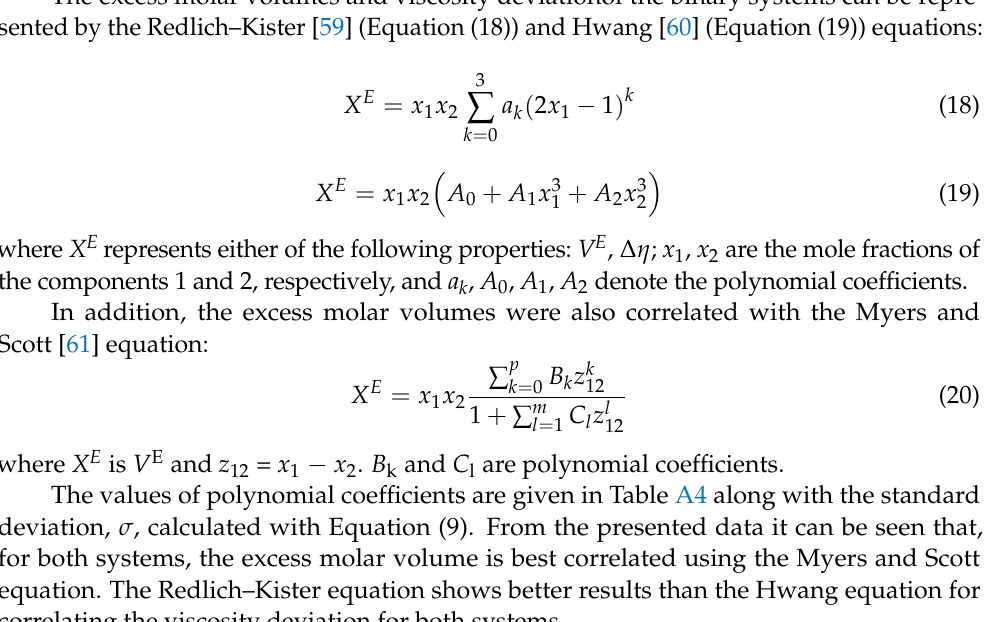
Figure 4. Viscosity deviation ( Δ η ) with mole fraction for MDEA (1) + DMSO (2) system at various temperatures: ■ 293.15 K; ● 298.15 K; ▲ 303.15 K; ▼ 308.15 K; ♦ 313.15K.